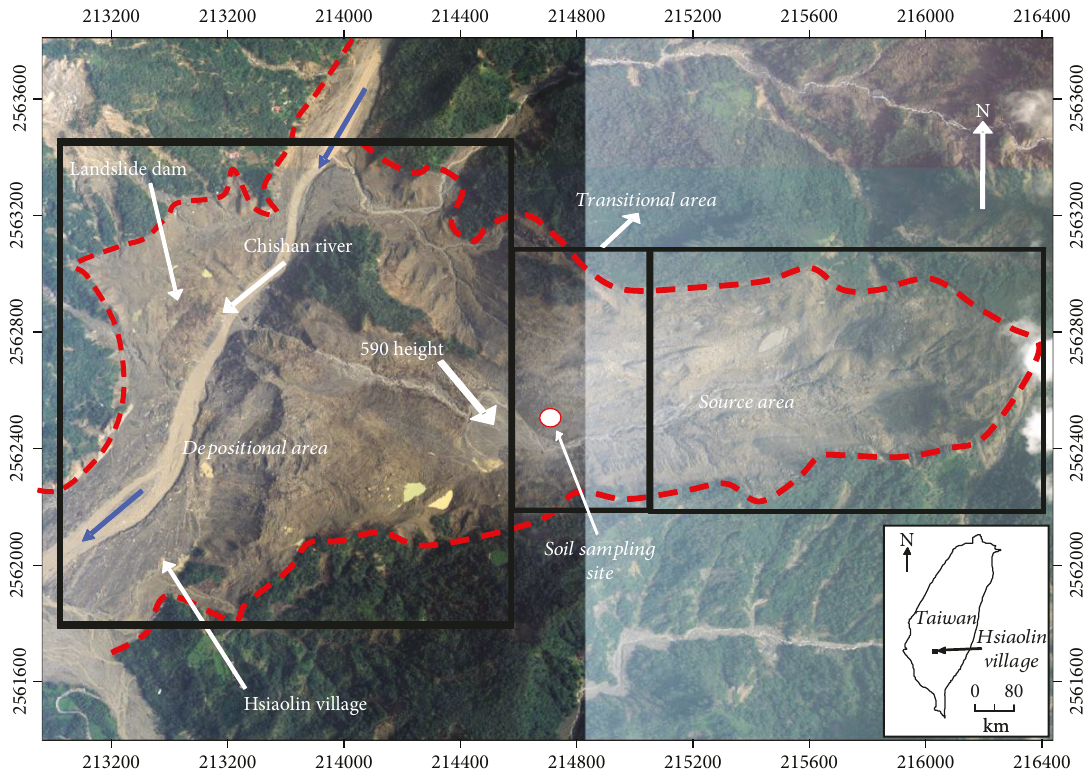
Figure 5: Aerial photo of the Hsien-du-shan rock